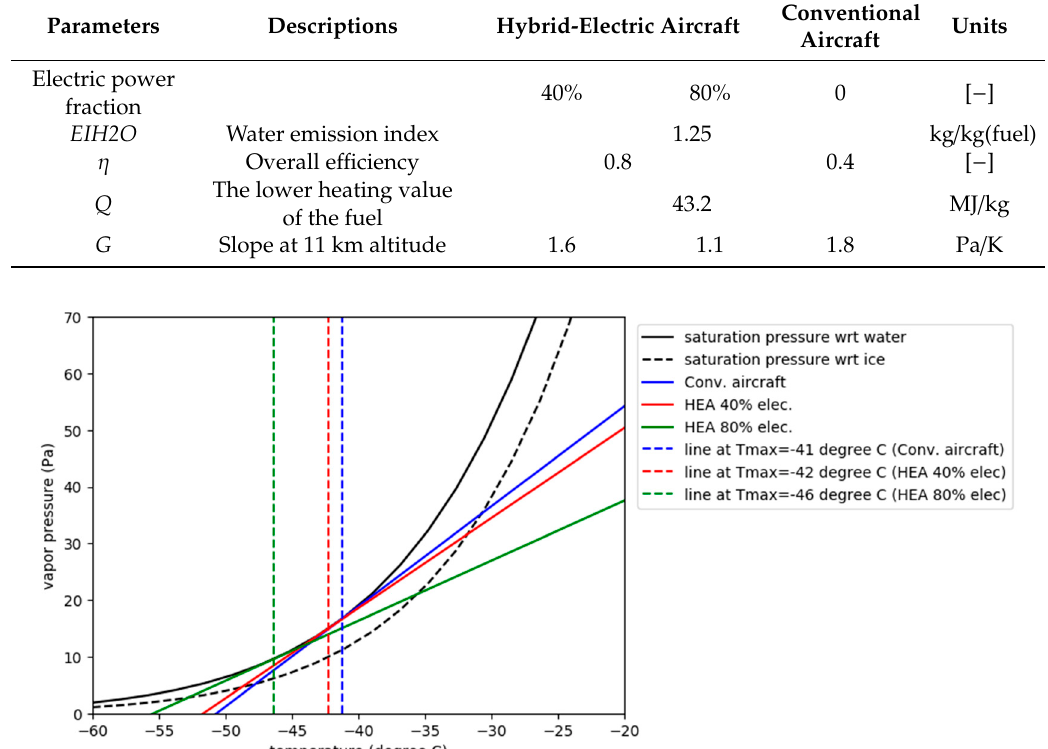
Table 1. Calculated parameters for the Schmidt–Appleman criterion on hybrid-electric aircraft.